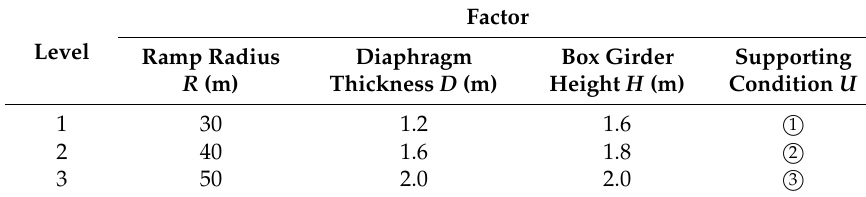
Table 6. Factors and levels for the orthogonal